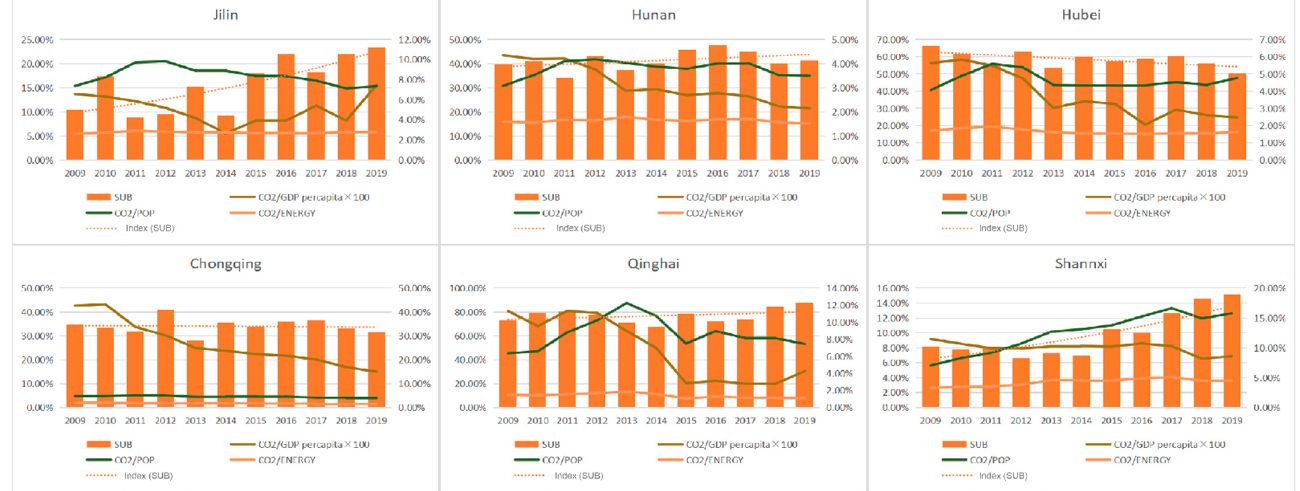
Figure 5. The Carbon Emission and SUB change across 30 provinces in China (2009–2019).